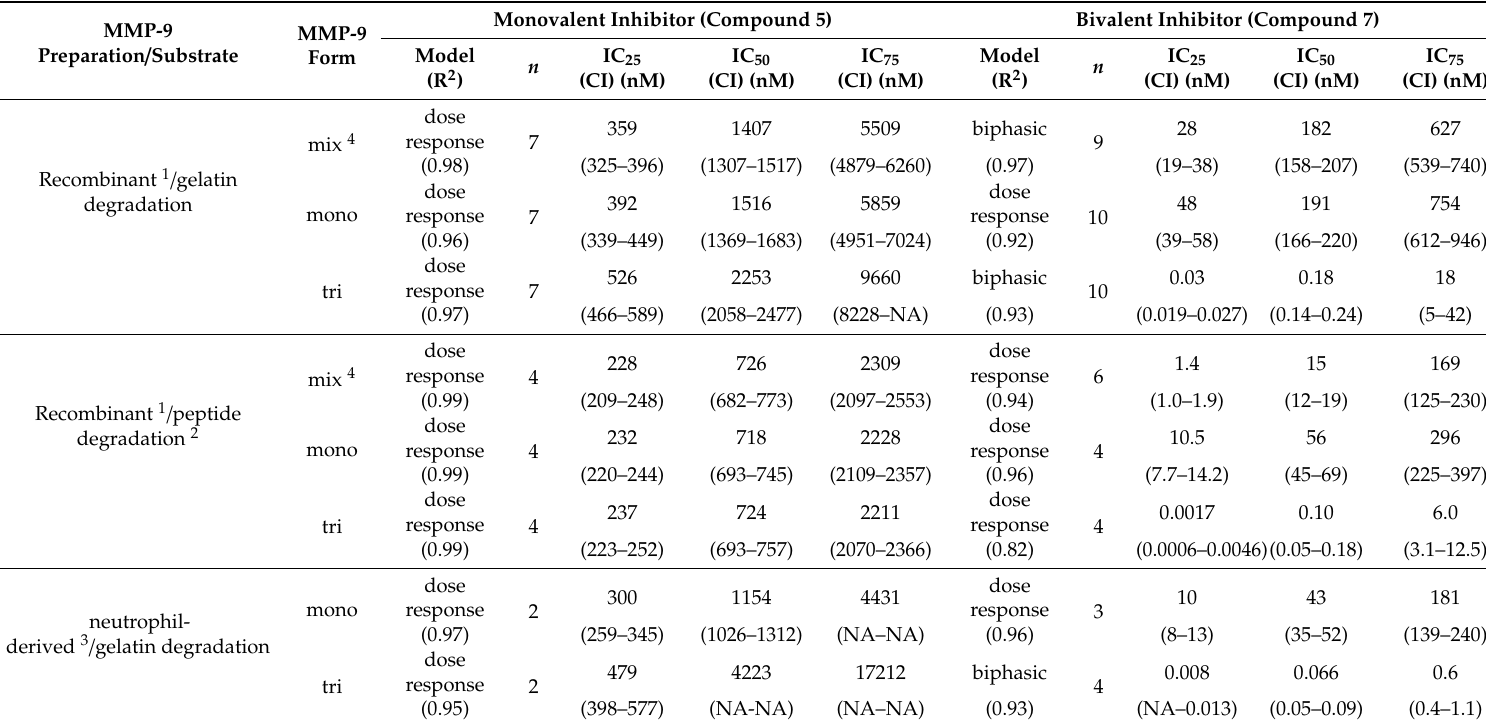
Table 1. Inhibitory capacity of a monovalent and the corresponding bivalent carboxylate inhibitor on gelatinolysis by MMP-9 monomers and